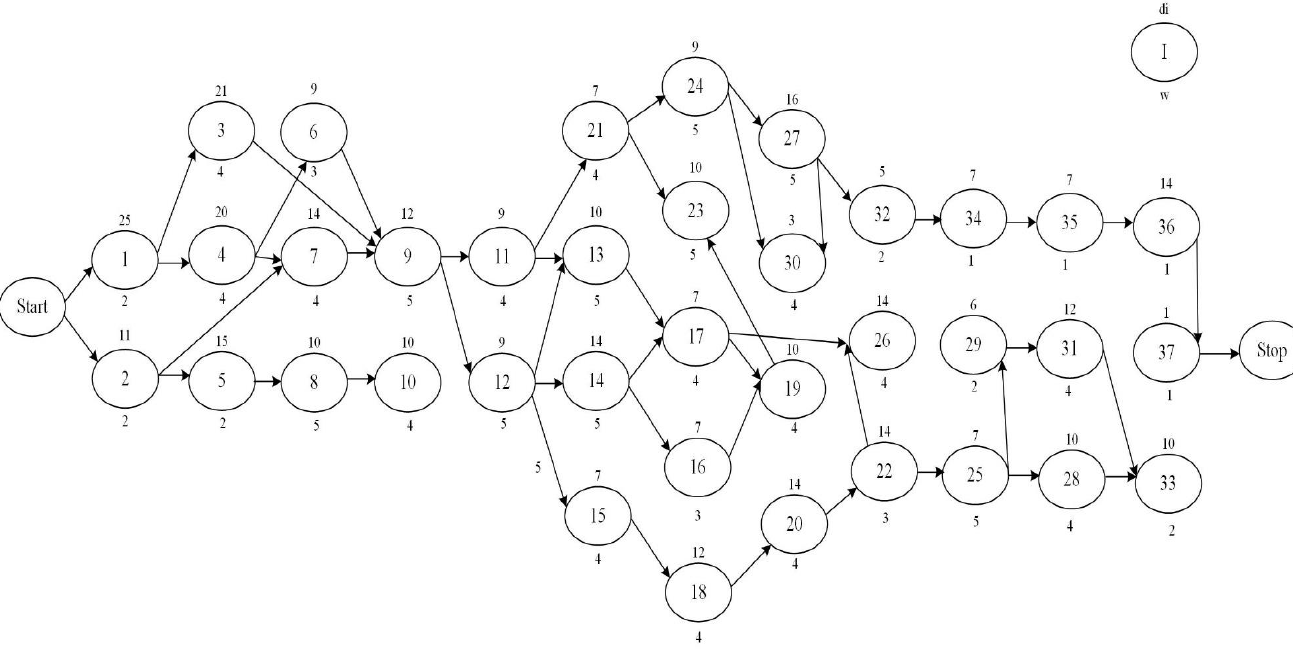
Figure 14. A typical RCPSP example with a daily labor limit=12